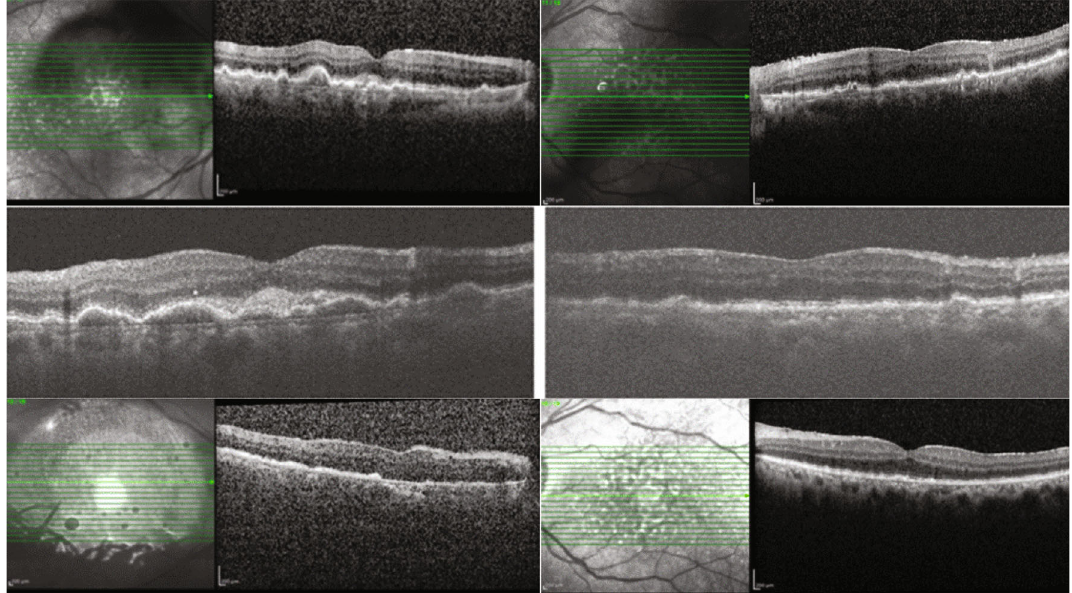
Figure 4: One month after starting the antiviral therapy, SD-OCT of the right eye (a) and the left eye (b) shows the exacerbation of the subretinal in fi ltration during the one-week follow-up period (the top and the middle rows). Two weeks after intravitreal injection of methotrexate and rituximab, signi fi cant improvement was observed in macular OCT (bottom